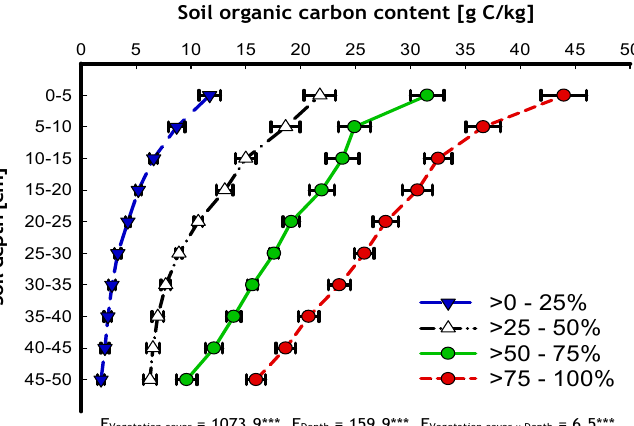
way analysis of variance (ANOVA); Vegetation cover: 0—25%, >25—50%, >50—75% and >75—